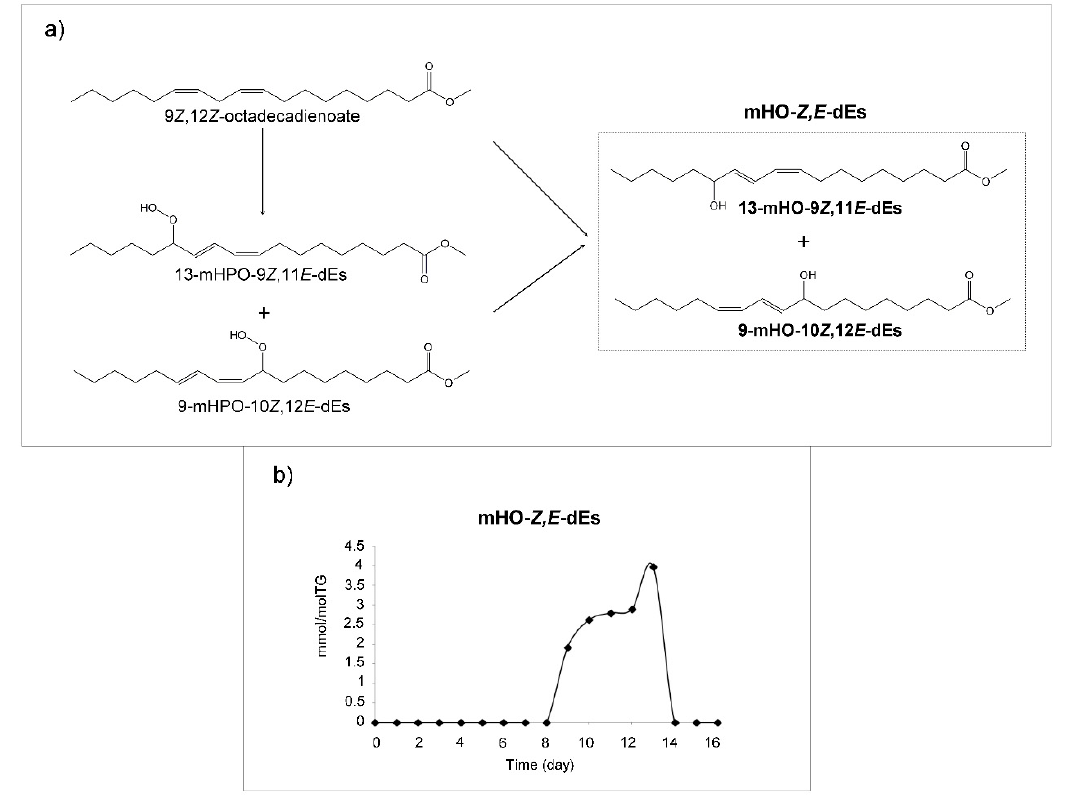
Figure 5. ( a ) Pathway of monohydroxy-conjugated -Z,E- dienes (mHO-c( Z,E )-dEs) formation proposed by some authors under certain oxidation conditions [61]. ( b ) Evolution of its concentration, expressed as mmol/mol TG versus time given in